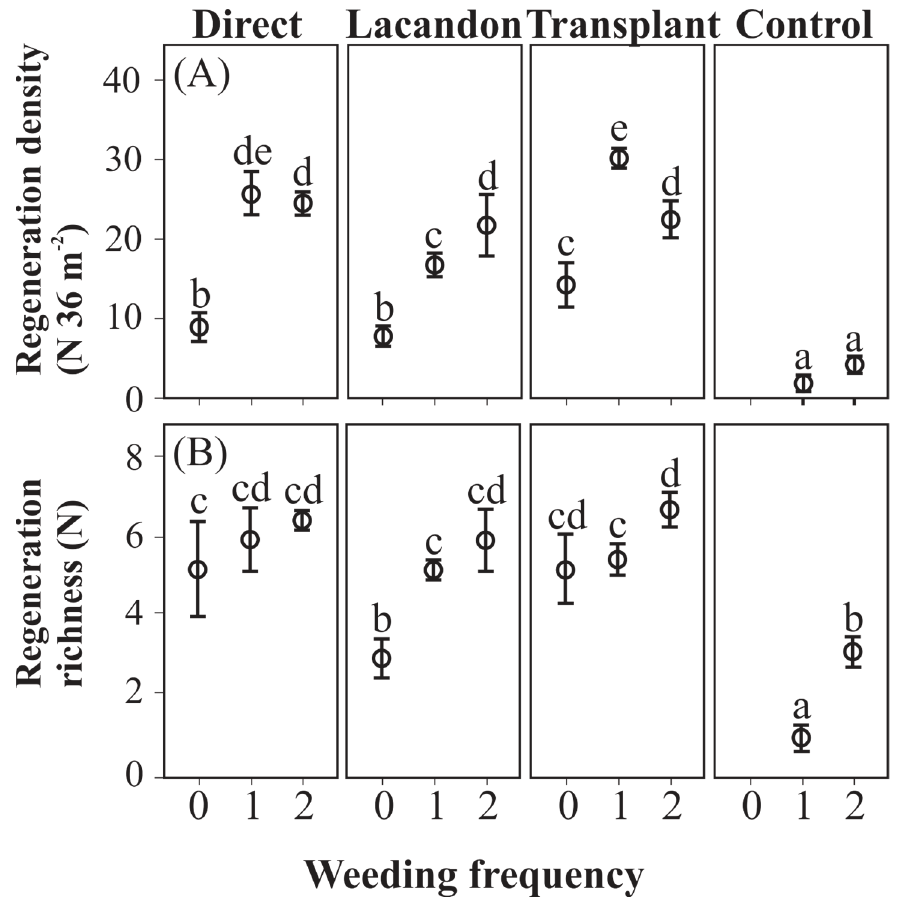
Figure 4. Mean and 95% confidence intervals for ( A ) regeneration density (36 m − 2 ) and ( B ) species richness per treatment and weeding intensity (0 = no weeding; 1 = monthly weeding; and 2 = biweekly weeding) as assessed four years after establishing treatments.